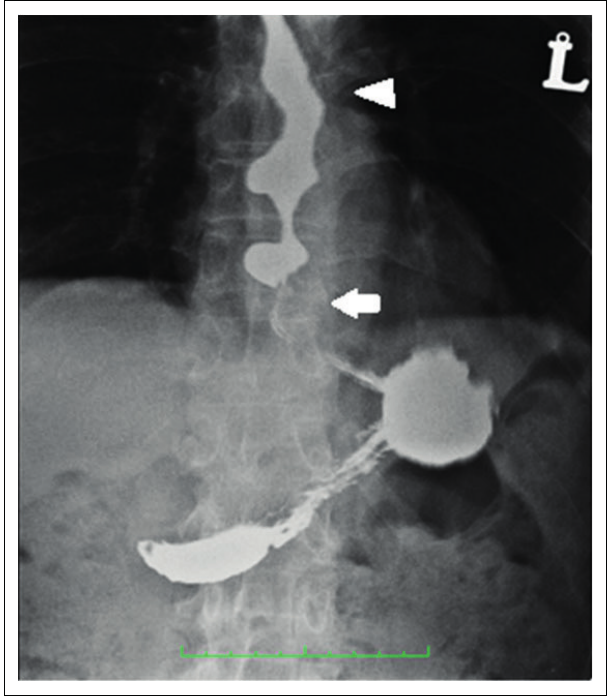
FIGURE 3: Barium swallow Antero – posterior (AP) view – Arrow denotes the spindle-shaped tapering of the lower end of the esophagus. Arrowhead denotes the tertiary